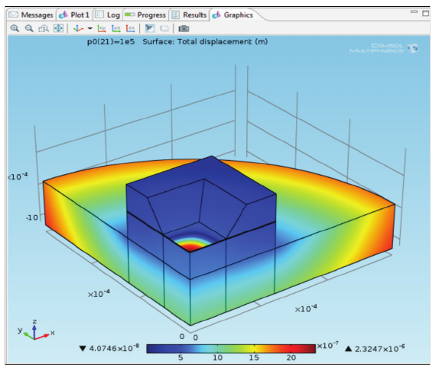
Figure 11: Structure surface of diaphragm with maximum applied pressure and temperature.